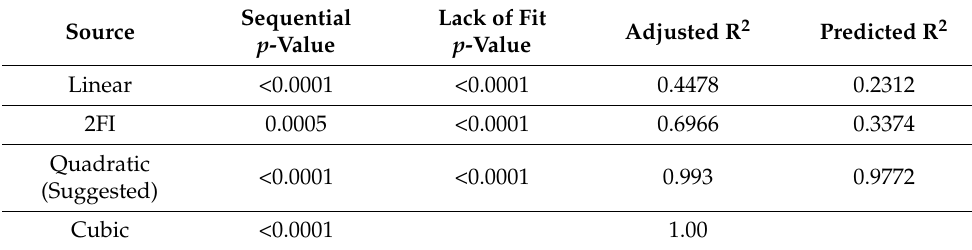
Table 8. Comparison of accuracy of chosen regression